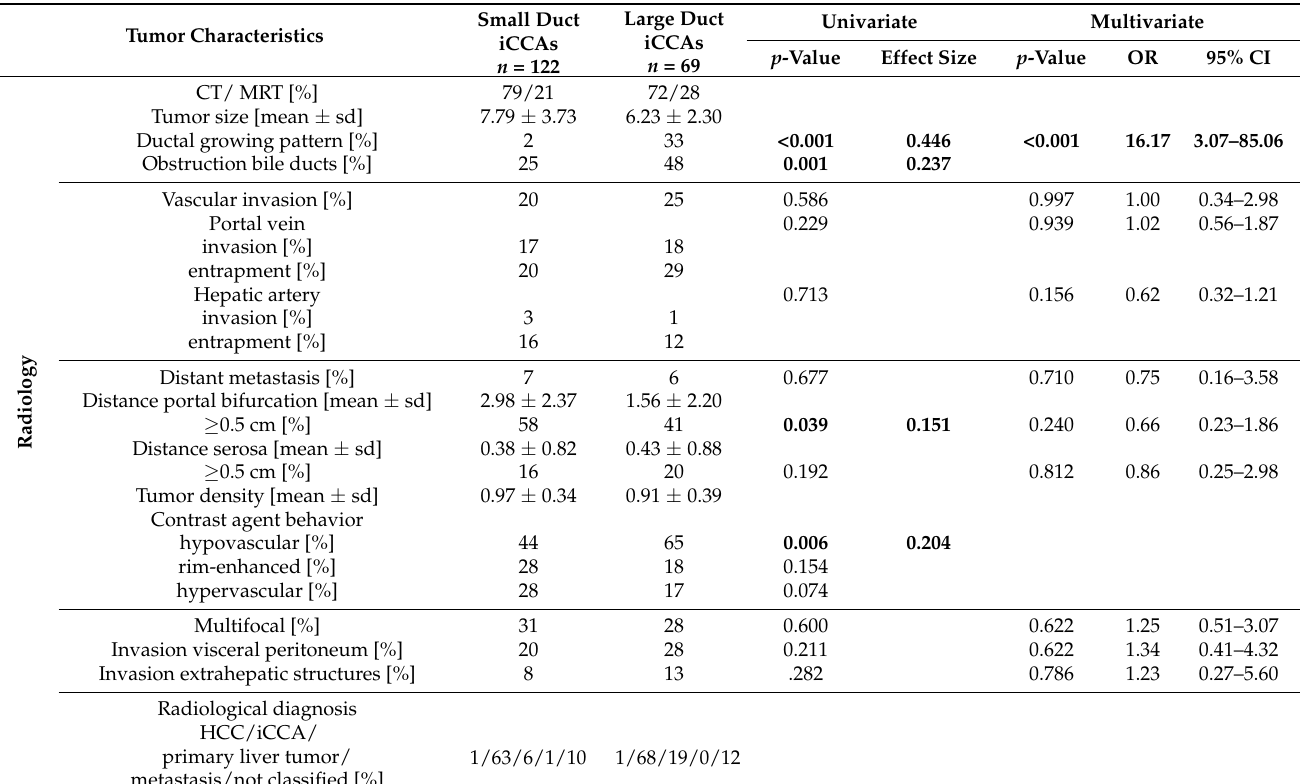
Table 2. Correlation of iCCA subtypes and radiologic